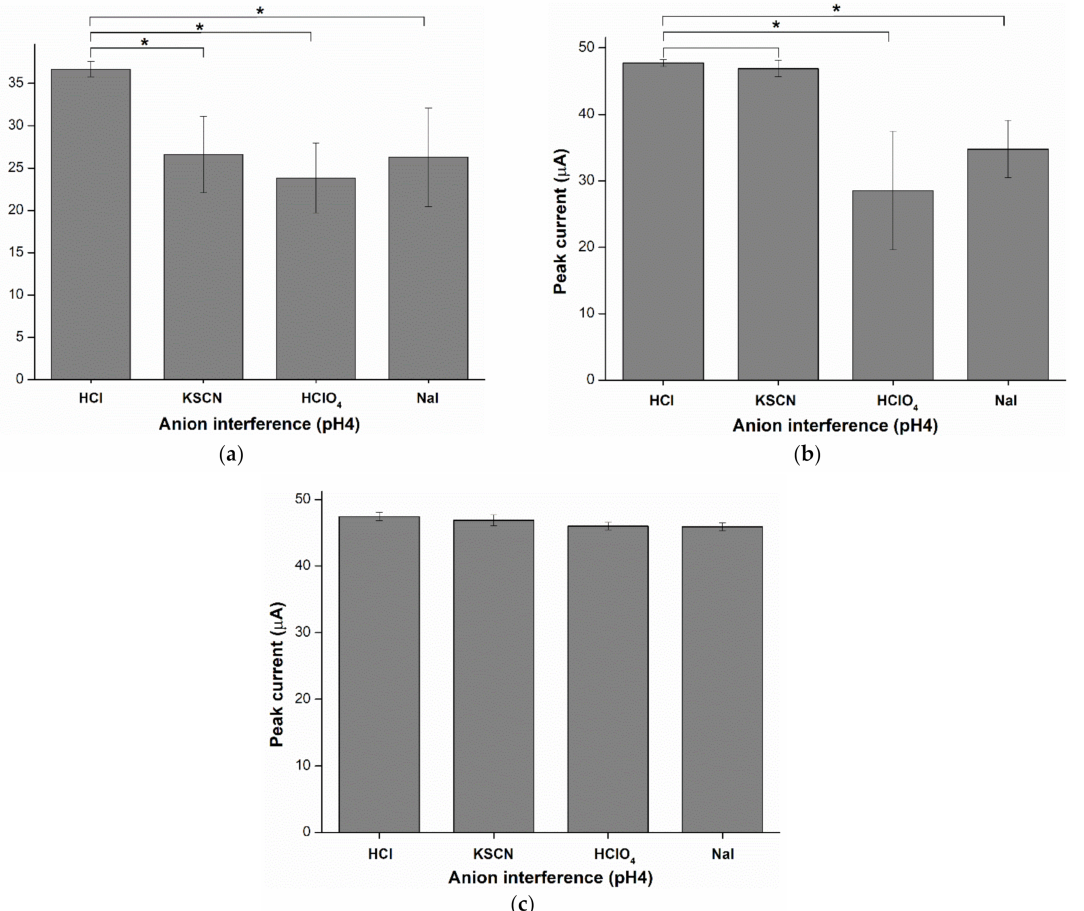
Figure 11. Coextraction of anion interferences affects the peak current of cadmium(II): ( a ) single (DOS) plasticizer sensor; ( b ) hybrid (DOS:TOTM) plasticizer sensor; ( c ) hybrid (DOS:TOTM) plasticizer sensor composed of TBACl ( n = 5), (* p -value < 0.05).